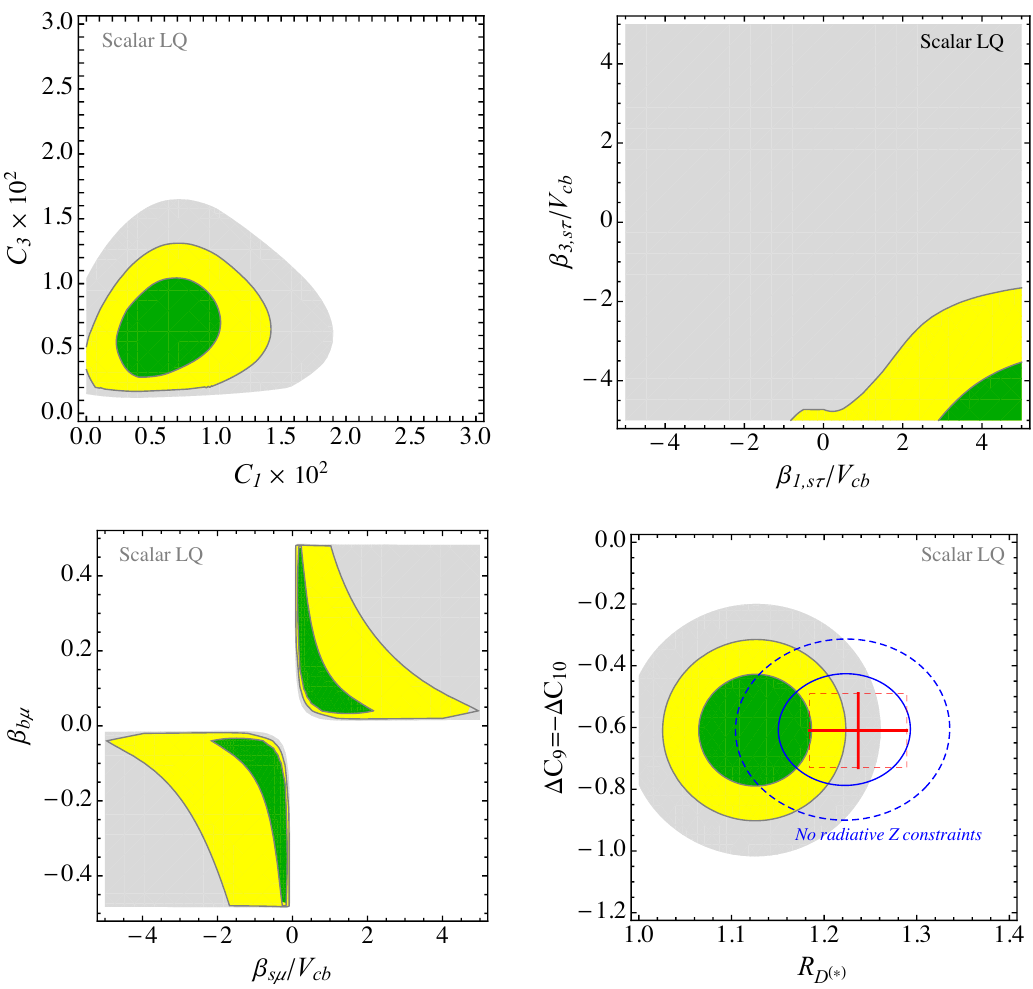
Figure 6 . Fit to the semi-leptonic and radiatively-generated purely leptonic observables in table 1, for the scalar leptoquarks S 1 and S 3 , imposing j (cid:12) s(cid:22);s(cid:28) j < 5 j V cb j and C 1 ; 3 > 0. In green, yellow, and gray, we show the (cid:1) (cid:31) 2 (cid:20) 2.3 (1 (cid:27) ), 6.2 (2 (cid:27) ), and 11.8 (3 (cid:27) ) regions, respectively. In the lower-right panel we show the preferred values of the (cid:12)t in the R , (cid:1) C (cid:22) plane, compared with the 1 (cid:27) D ( (cid:3) ) 9 experimental measurements (red box). Removing Z ! (cid:28) (cid:22) (cid:28); (cid:23) (cid:22) (cid:23) radiative constraints from the (cid:12)t, the 1- and 2 (cid:27) preferred regions in this case are shown with solid and dashed blue